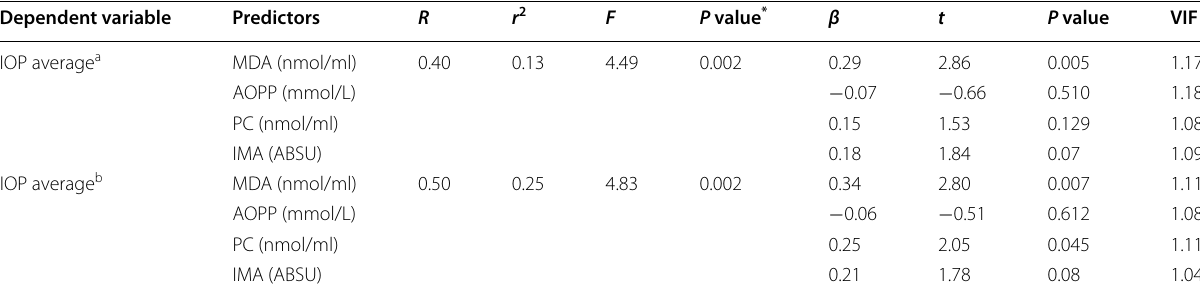
Table 5 Multiple linear regression analysis for the association of systemic oxidative stress markers with the IOP average